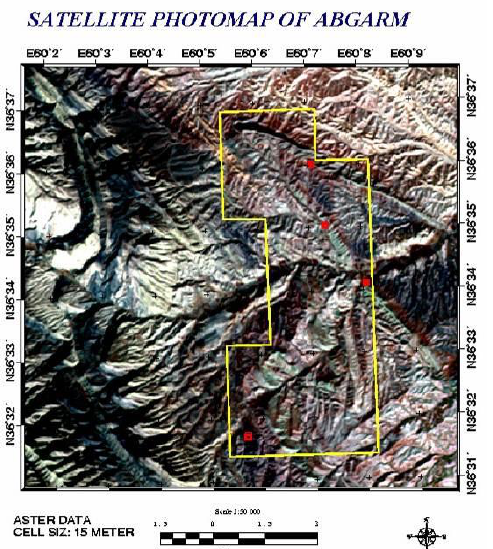
Figure 4. ASTER colour image RGB: 468, Glauconite units are in greenish blue color (check points are red).